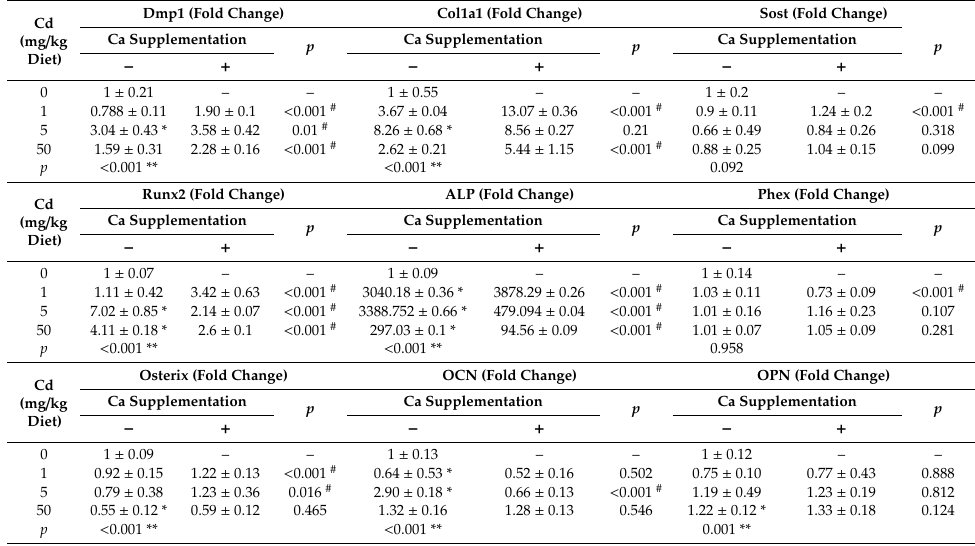
Table 11. Expression changes of osteogenic formation in the femurs using quantitative real-time polymerase chain reaction in the study of moderate Ca supplementation exposure to different diet Cd (Exp